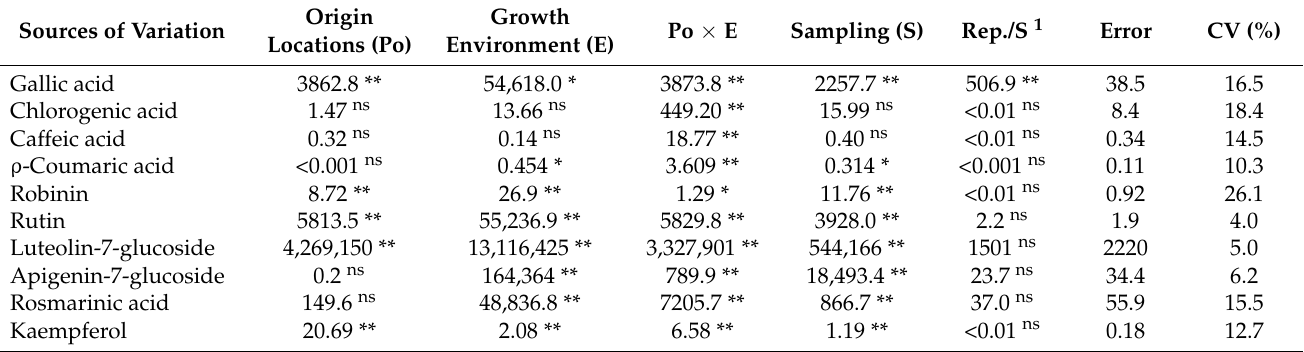
Table 4. Significance of square means of analysis of variance regarding phenolic acids and flavonoids evaluated in A. petiolaris by HPLC-DAD.